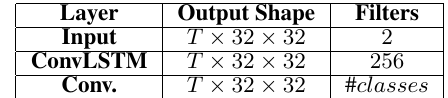
Table 1. UConvLSTM parameter configuration - T is the